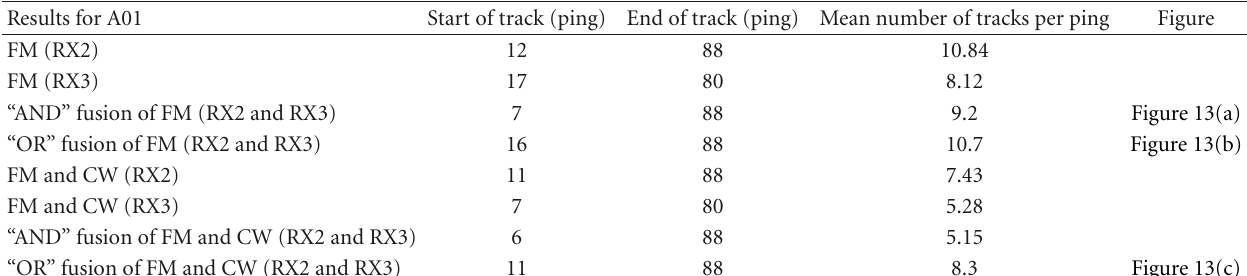
Table 4: Tracking results for